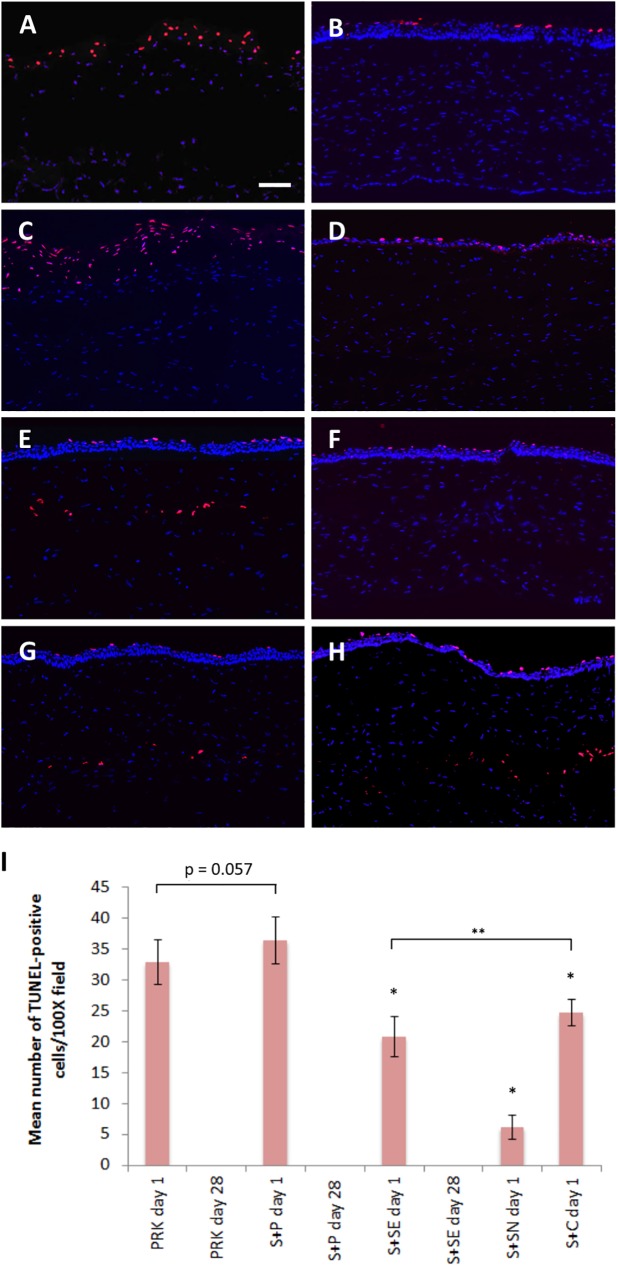
Apoptotic cells in the central cornea after SMILE retreatment.(A) Abundant of TUNEL-positive cells was present at the superficial layers of the exposed stroma on day 1 after PRK alone treatment (PRK day 1 group). (B) TUNEL staining was negative in the stroma after 28 days (PRK day 28 group). (C) Similar staining pattern to PRK day 1 group could be seen in S+P day 1 group. (D) On day 28 post-enhancement with surface ablation, no apoptotic cells was visible in the stroma (S+P day 28 group). (E) Relatively less apoptotic cells were seen along the cap interface of the secondary SMILE on post-enhancement day 1 (S+SE day 1 group). (F) No TUNEL-positive cells was observed along the cap interface after 28 days (S+SE day 28 group). (G) Some apoptotic cells were present although the lenticule was left not extracted in S+SN day 1 group. (H) Apoptotic cells were observed on day 1 along the flap interface after flap creation using VisuMax Circle software and subsequent stromal excimer ablation (S+C day 1 group). (E) Quantification of TUNEL-positive cells in the central corneal stroma after different SMILE retreatment methods. Data were analyzed using one way ANOVA and a post hoc Tukey comparison procedure. *p<0.001 relative to S+P day 1 group. **p<0.001. Scale bar = 50 μm.